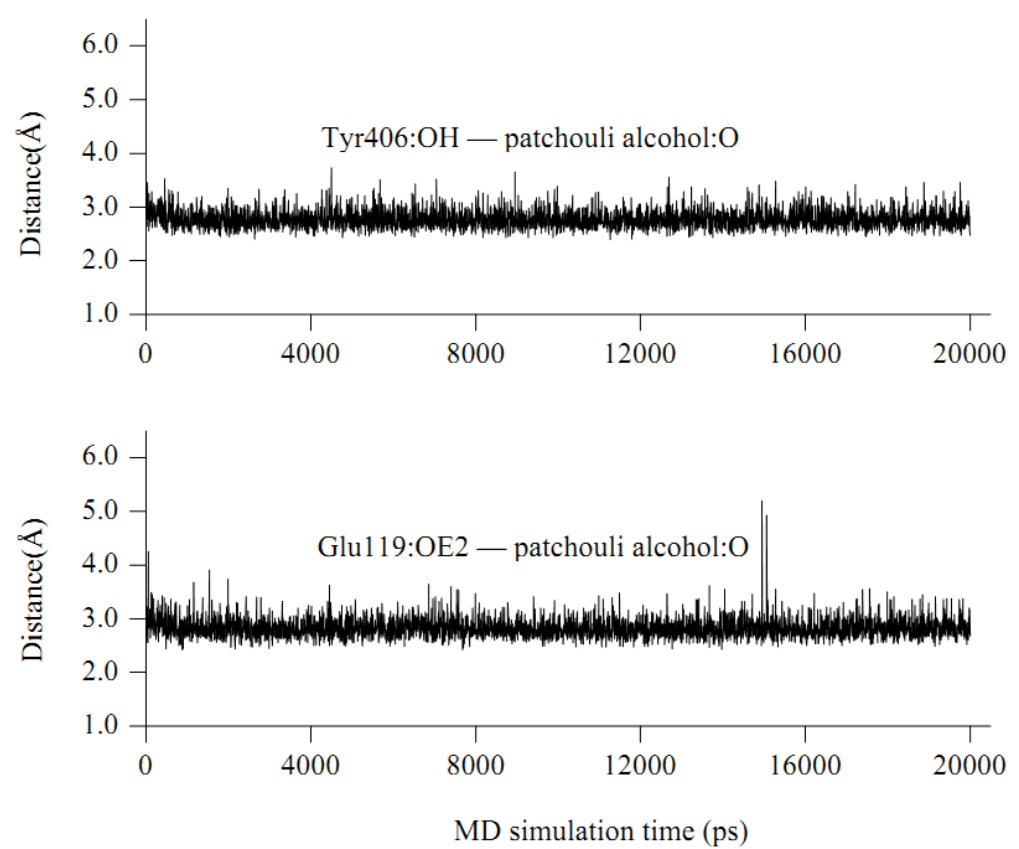
Figure 6. Some time-evolution distances between patchouli alcohol and NA